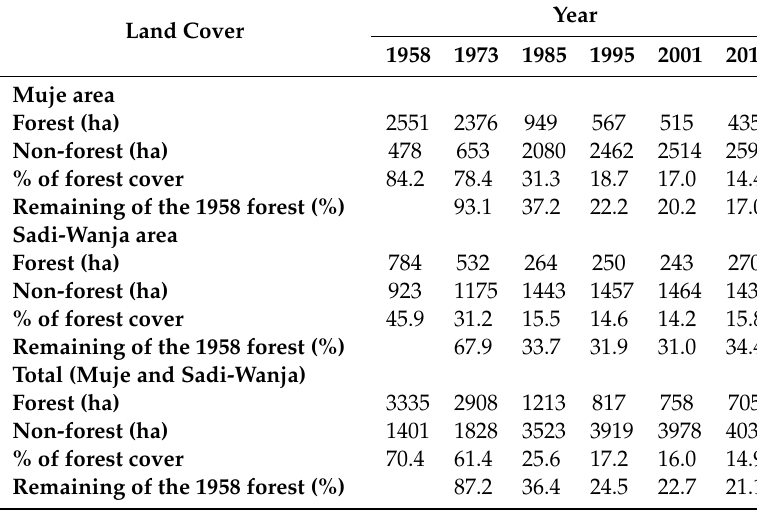
Table A4. Changes in the composition of the fields used by the farmers interviewed in Gera in 2011. †